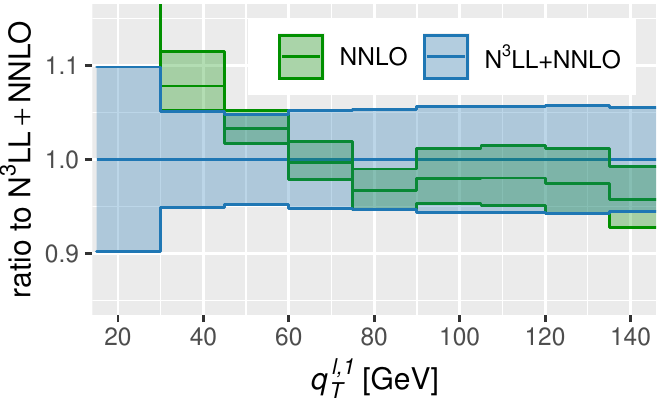
Figure 4 . The q l 1 distribution at NNLO as a ratio to N 3 LL+NNLO. See figure 3 for the sum of T all leptons compared to CMS